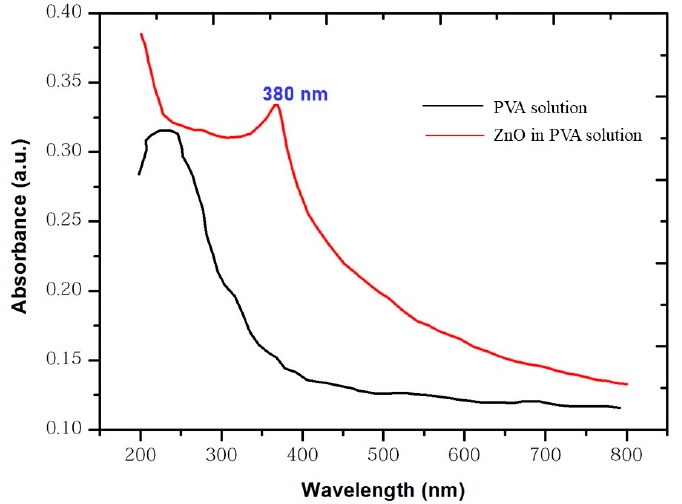
Figure 9. UV–visible spectrum of plain PVA solution and ZnO NPs embedded PVA solution.